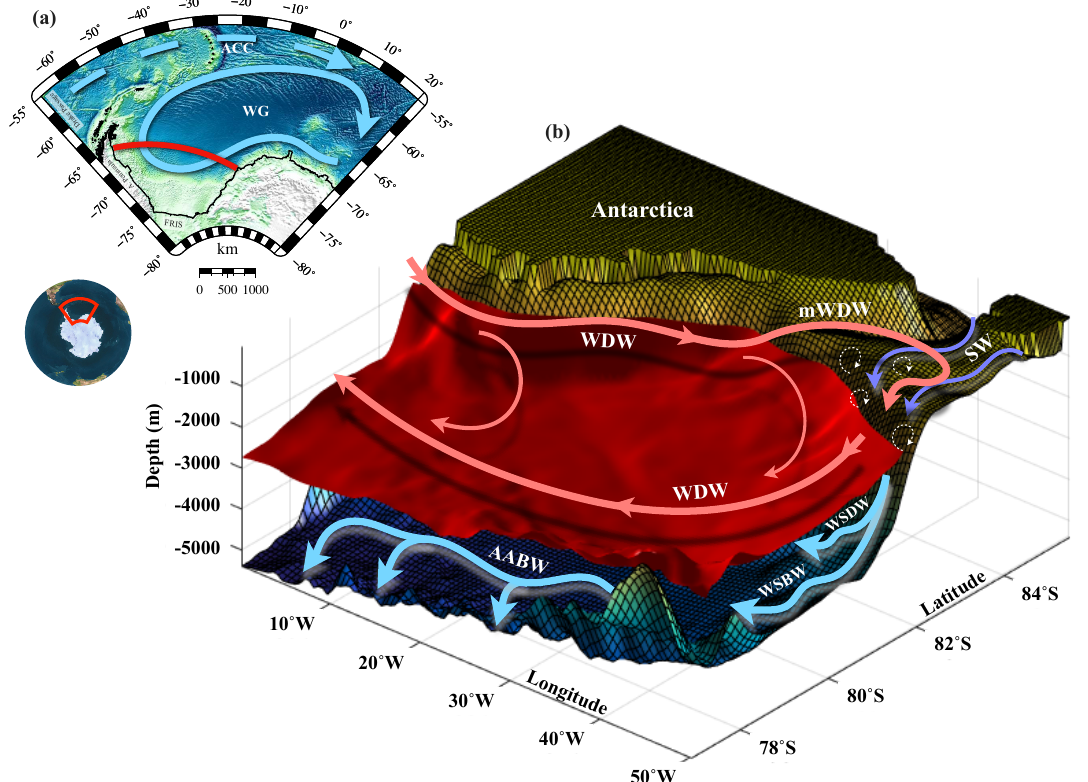
Figure 1. ( a ) Atlantic sector of the Southern Ocean topography centered at the Weddell Sea. The full blue arrow represents the Weddell Gyre (WG) circulation and the dashed blue arrow represents the Antarctic Circumpolar Current (ACC) flow. The red line marks the transect assessed with the OMP for WDW investigation throughout the LM, encompassing the inflow and outflow regions of the WG. ( b ) Perspective of the Weddell Sea multi-layer circulation, depicting the near–shelf break interactions between the WDW (coral arrow) and the super cooled Shelf Waters (SW—purple arrows) to form the WSDW and WSBW, ultimately exported as AABW (light blue